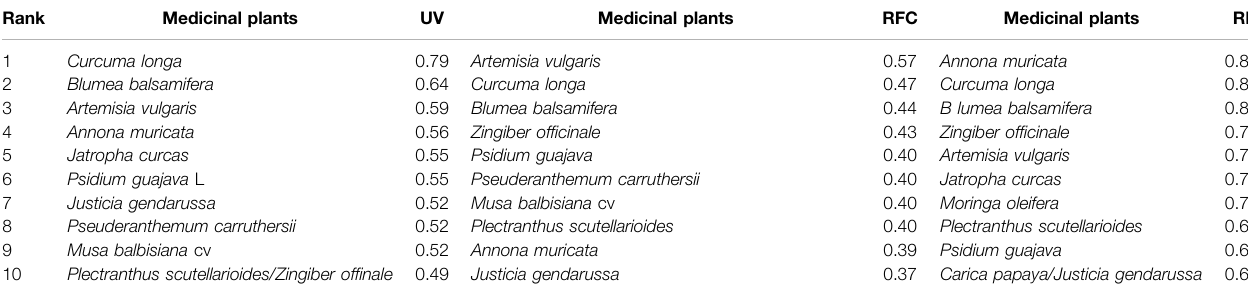
TABLE 2 | Top ten medicinal plants with the highest UV, RFC, and RI